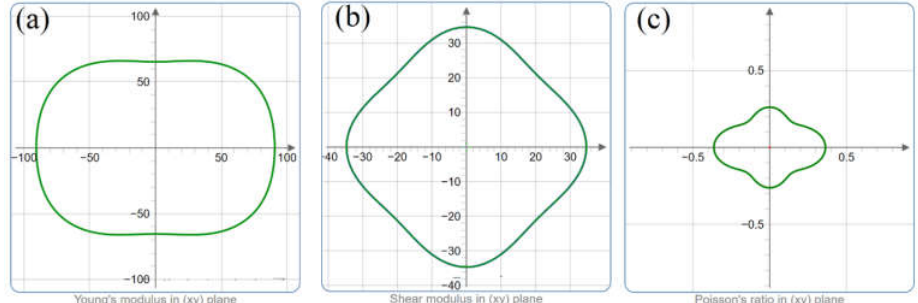
Figure 5. Spatial dependencies of ( a ) the Young’s modulus, ( b ) the shear modulus, and ( c ) Poisson’s ratio for the Cu 2 TeO 6 monolayer.